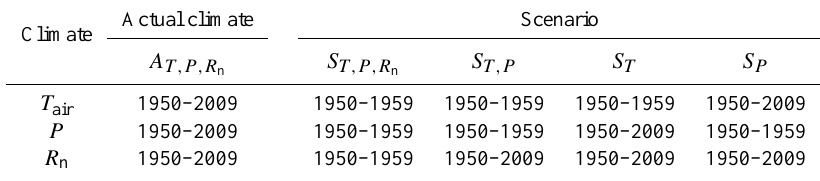
Table 1. Description of the climate conditions for simulating CH 4 emissions from